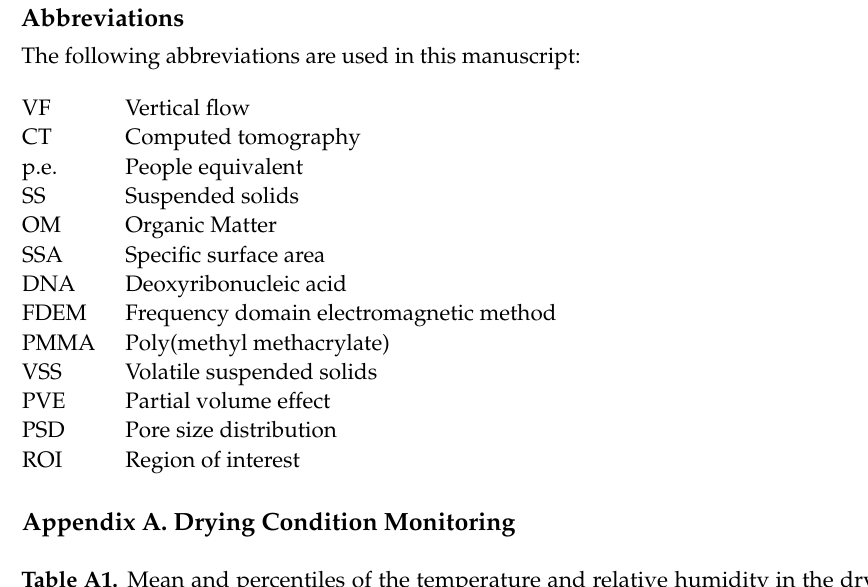
Table A1. Mean and percentiles of the temperature and relative humidity in the drying chamber